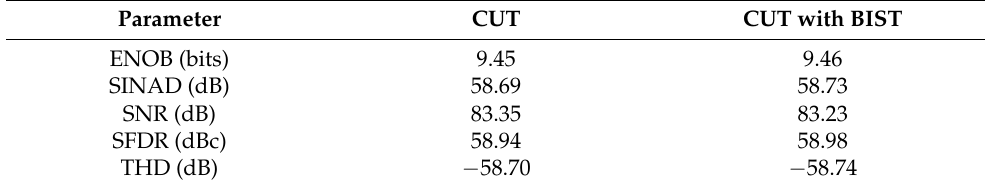
Table 1. Parameters comparison with and without BIST circuit.